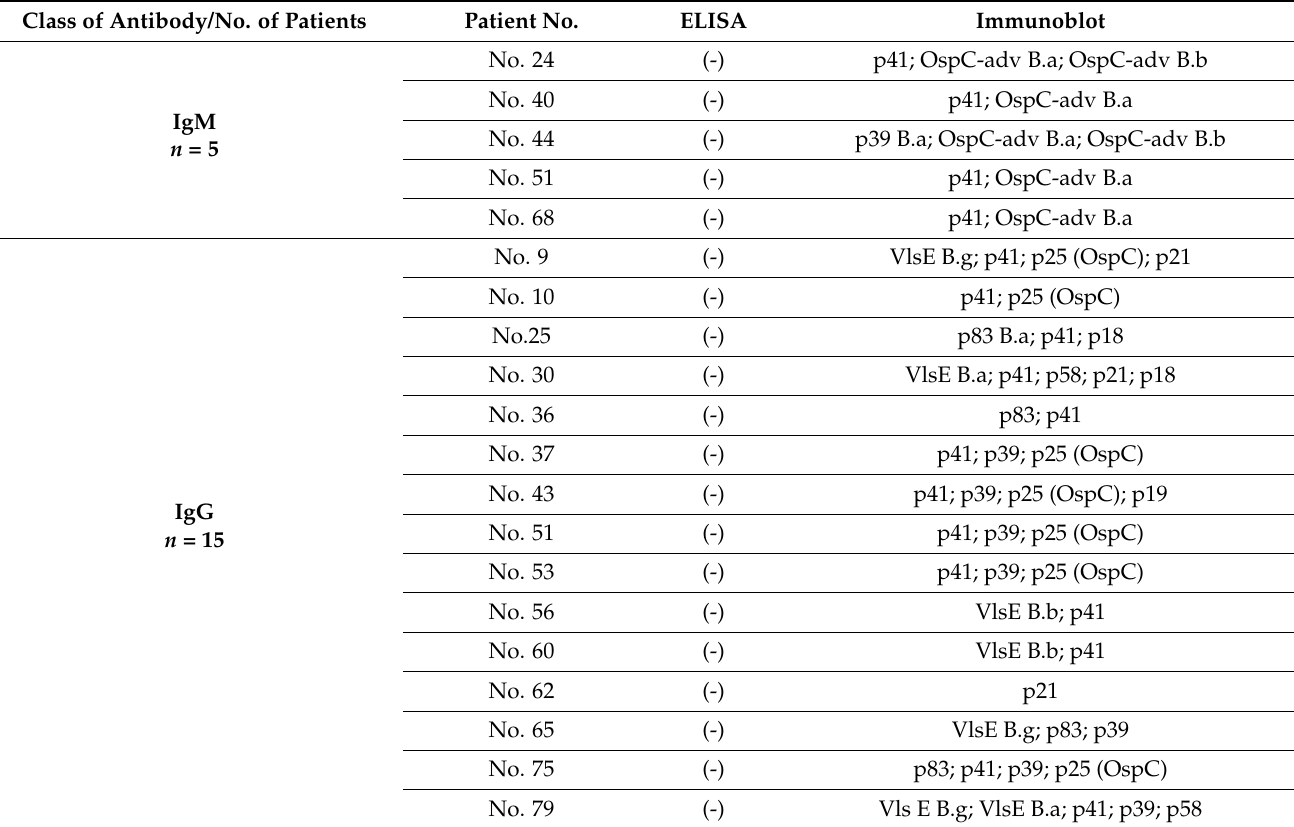
Table 2. Characteristics of antigens of blot reactivity with false-negative enzyme-linked immunosorbent (ELISA) assay in Lyme disease patients. Class of Antibody/No. of Patients Patient No. ELISA